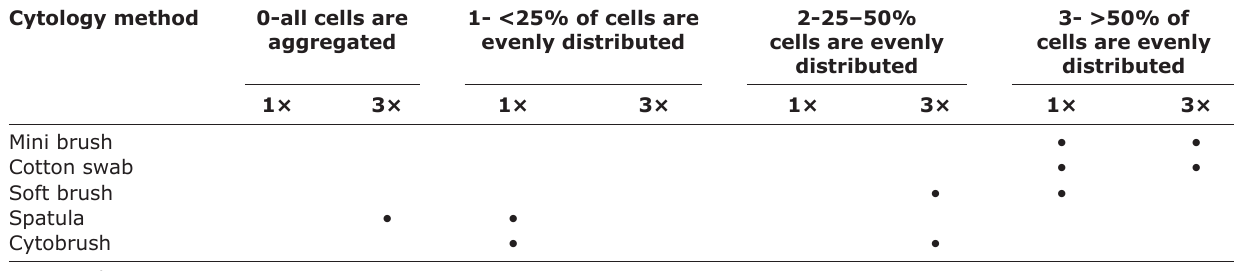
Table-3: Cell distribution 0–3; 0=all cells are aggregated, 1 = <25% cells are evenly distributed, 2=25–50% cells are evenly distributed, 3 = >50% cells are evenly distributed. Cytology method